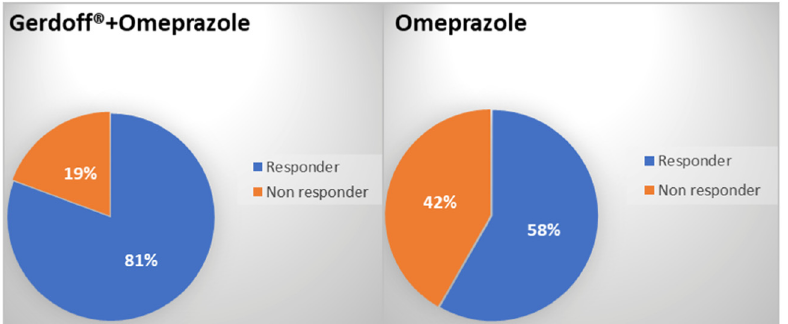
Figure 2. Distribution of responders at week 6 in the two groups. The percentages of responders at Week 6 in the treatment groups (Gerdoff ® + omeprazole or omeprazole) were reported ( p = 0.0496 in the Chi-squared test).